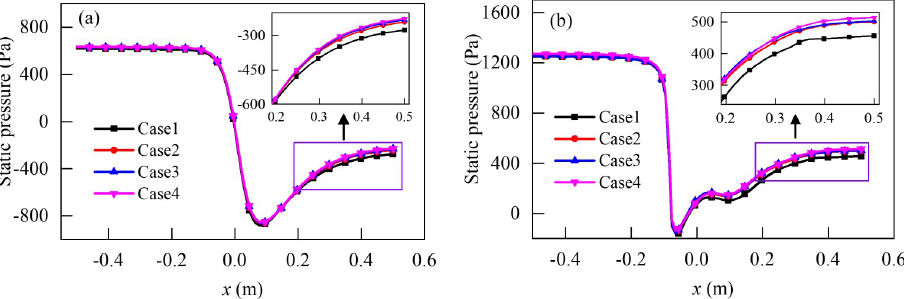
Fig 5. Static pressure along the x axis in the pipe at different grid schemes ( η = 49%). (a) Air-ring flow regulating valve. (b) Center butterfly valve.